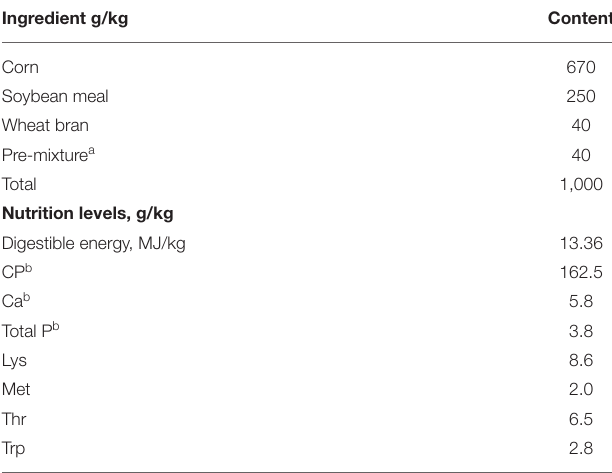
TABLE 1 | Composition and nutrient levels of the basal